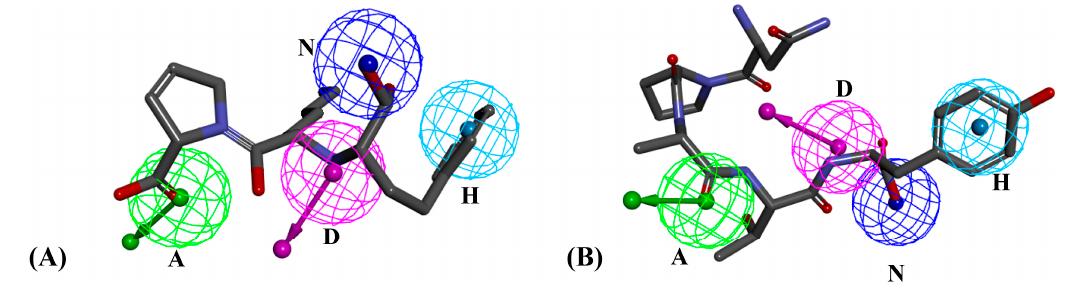
Figure 5. Matching graphs of ACE pharmacophore model and ligands: Lisinopril matched pharmacophore with fit value of 0.947 ( A ); and NPATY matched pharmacophore with fit value of 0.969 ( B ). Wherein, green features represent hydrogen bond acceptor; pink features represent hydrogen bond donor; dark blue features represent negative ionizable group; and light blue features represent hydrophobic group.